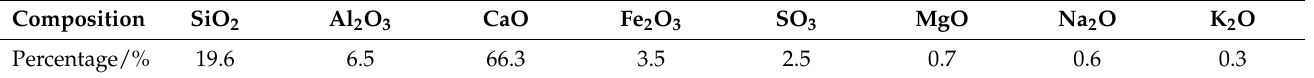
Table 2. The characteristic parameters of cement.